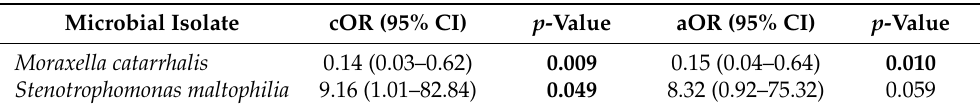
Table 4. Microbial risk factors associated with COVID-19 infection.